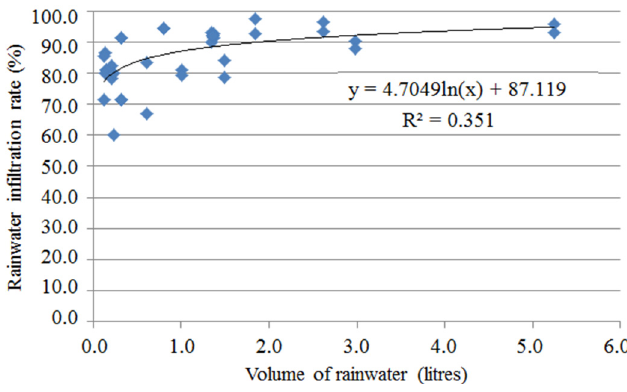
Figure 3. Rainwater infiltration through the slabs as a function of the total amount of rainwater collected in each event.